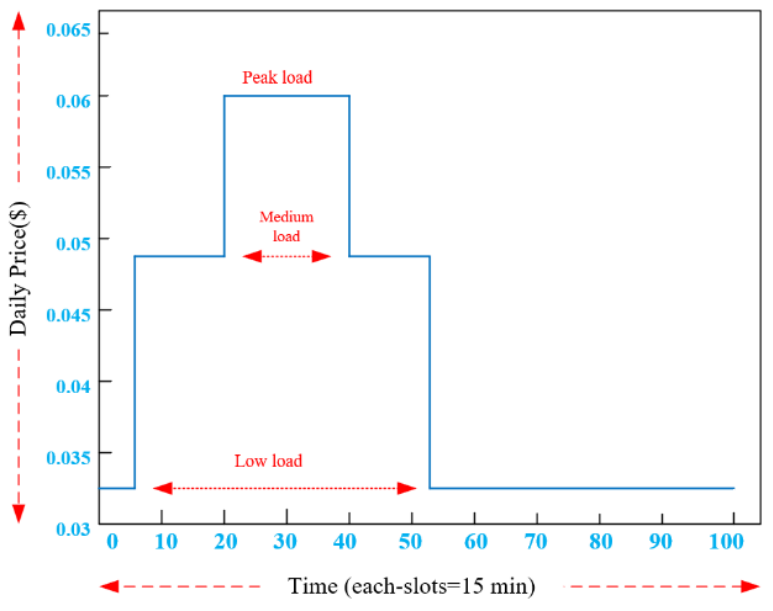
Figure 9. Different electricity tariffs.